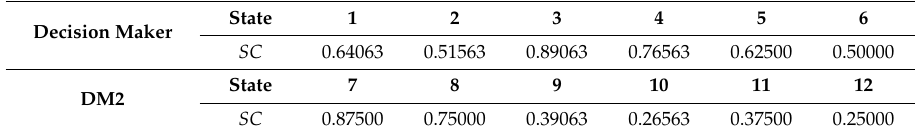
Table 9. SC of BPC.